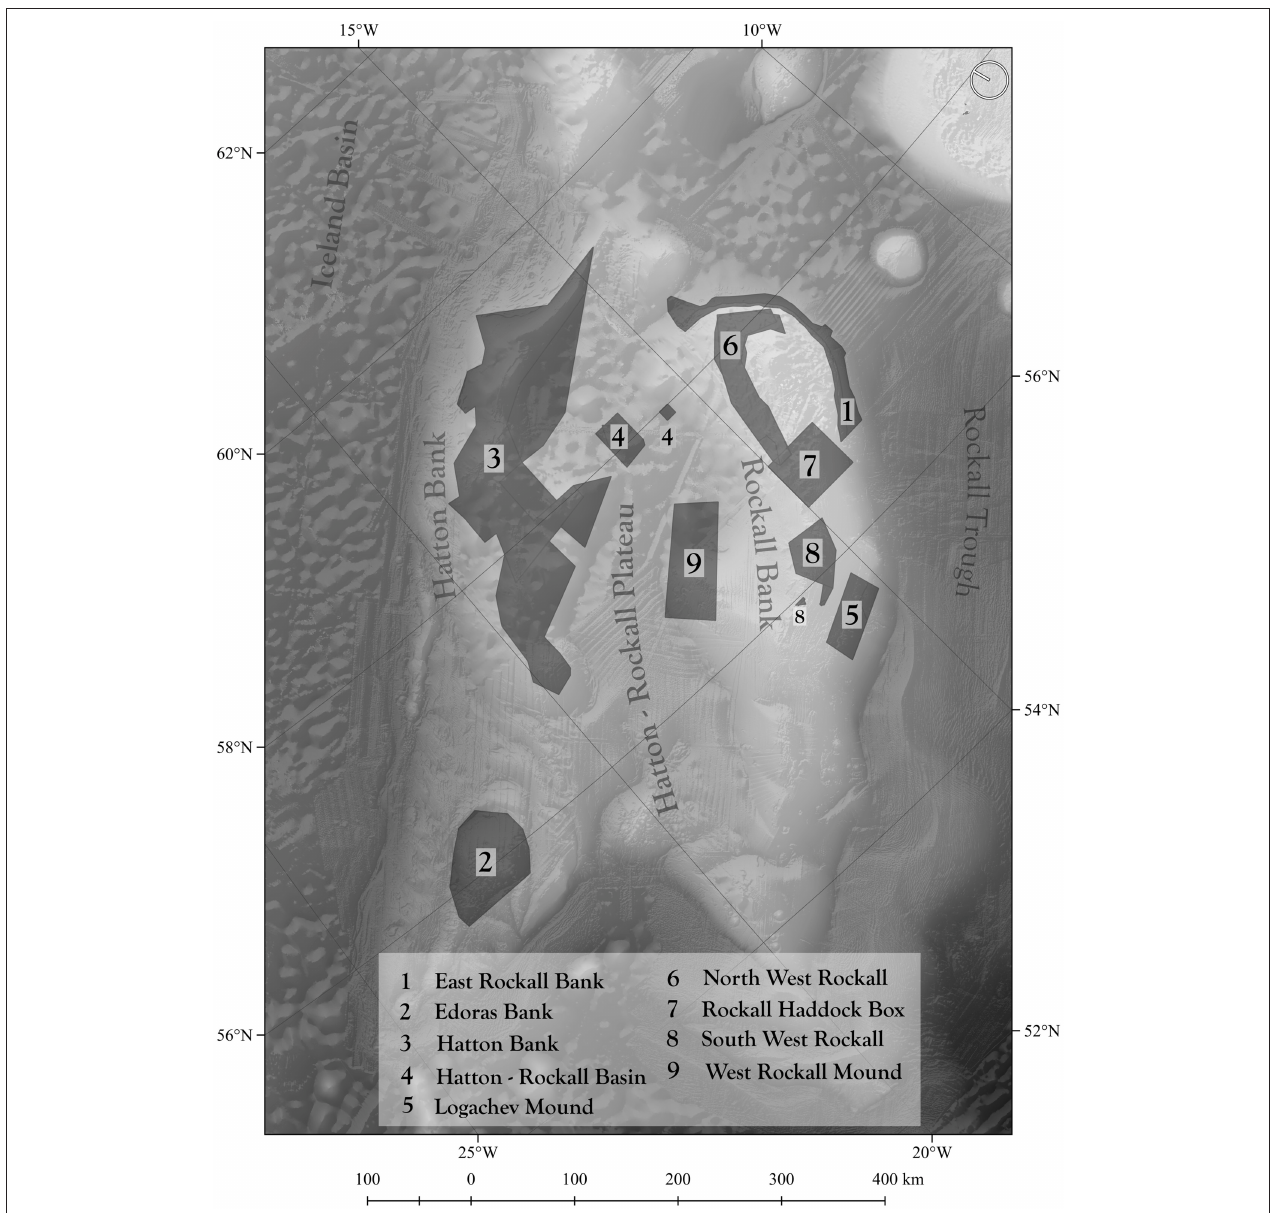
FIGURE 2 | The location of spatial management measures presently in effect at the Hatton–Rockall